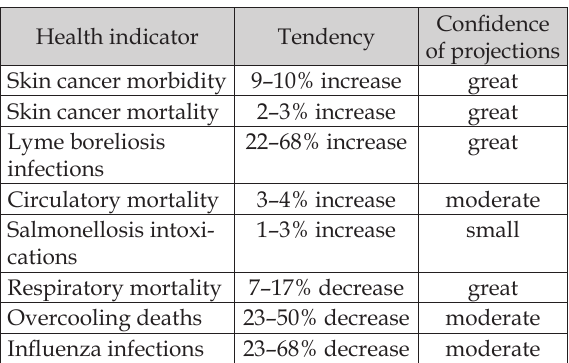
Table 3. Projected changes of the indicators of climate related diseases in Poland for the years